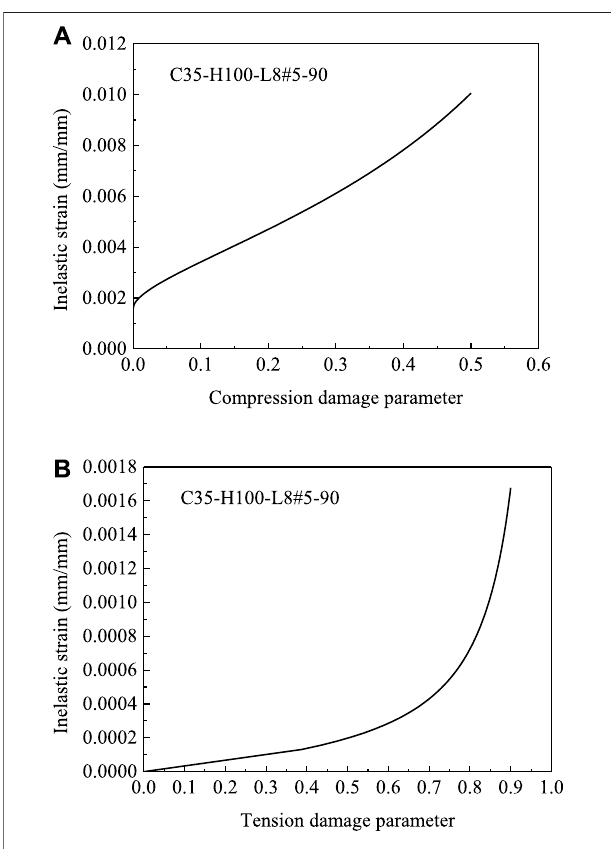
FIGURE 5 | The inelastic strain of con fi ned specimen C35-H100-L8#5- 90-CF versus the damage parameter; (A) for the concrete under compression; (B) for the concrete under